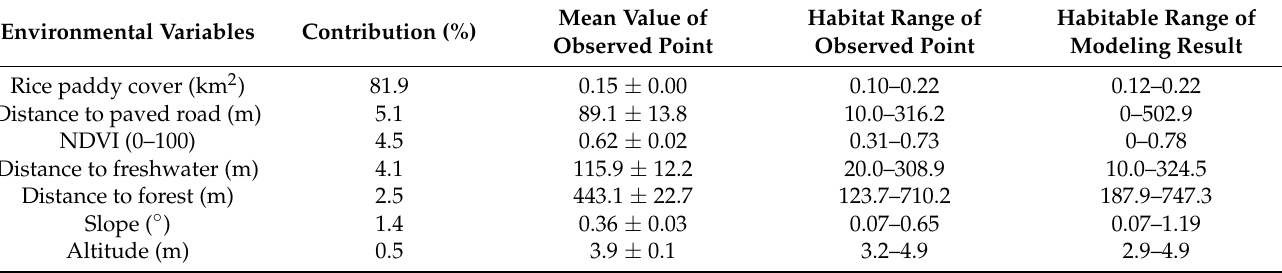
Table 1. Environmental values at the locality where Dryophytes suweonensis was observed (sites A, B, C and D; Figure 1) in Siheung in 2012, 2015 and 2019. This table highlights the relationship between habitat suitability values, ranges of model results and contribution of each environmental